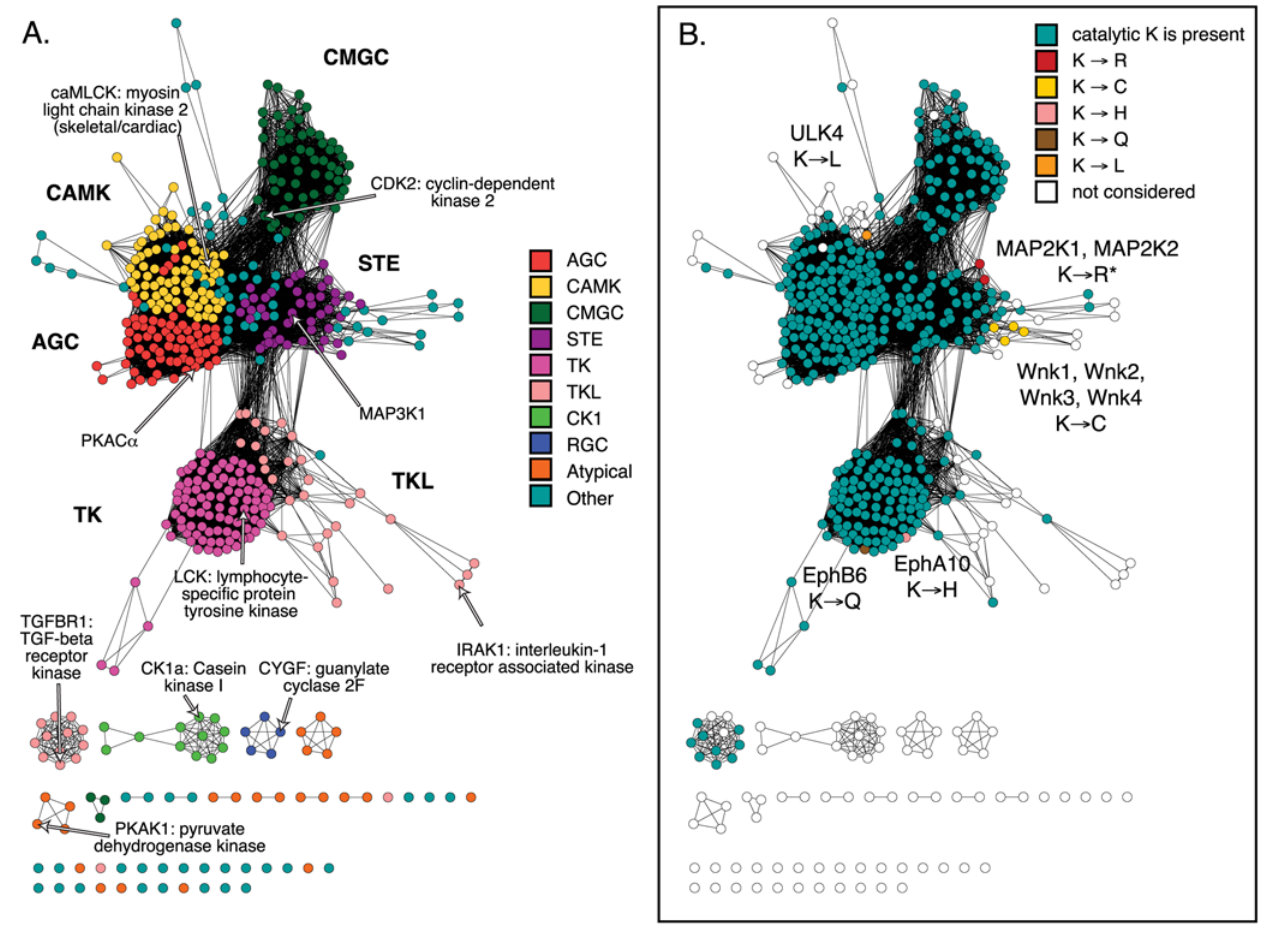
Figure 3. Sequence similarity networks are useful tools for exploration of the kinase superfamily. Two ways of coloring the same network of 513 human kinase domains are shown. The network is thresholded at a BLAST E-value of 1 6 10 2 25 . The worst edges displayed correspond to a median of 29% identity over alignments of 260 residues. A. Network colored by kinase class. B. Network colored by the presence of a catalytic Lys in the ‘‘VAIK’’ motif: Each of the 513 sequences was aligned to a sequence model of the kinase domain, and the identity of the residue at the catalytic Lys position is mapped to the network. *Note that MAP2K1 and MAP2K2 registered a Lys to Arg substitution due to a sequence alignment error. The other labeled kinases truly do not contain a homologous catalytic K, but only the WNK kinases have been shown to have kinase activity. See Table II for statistics.